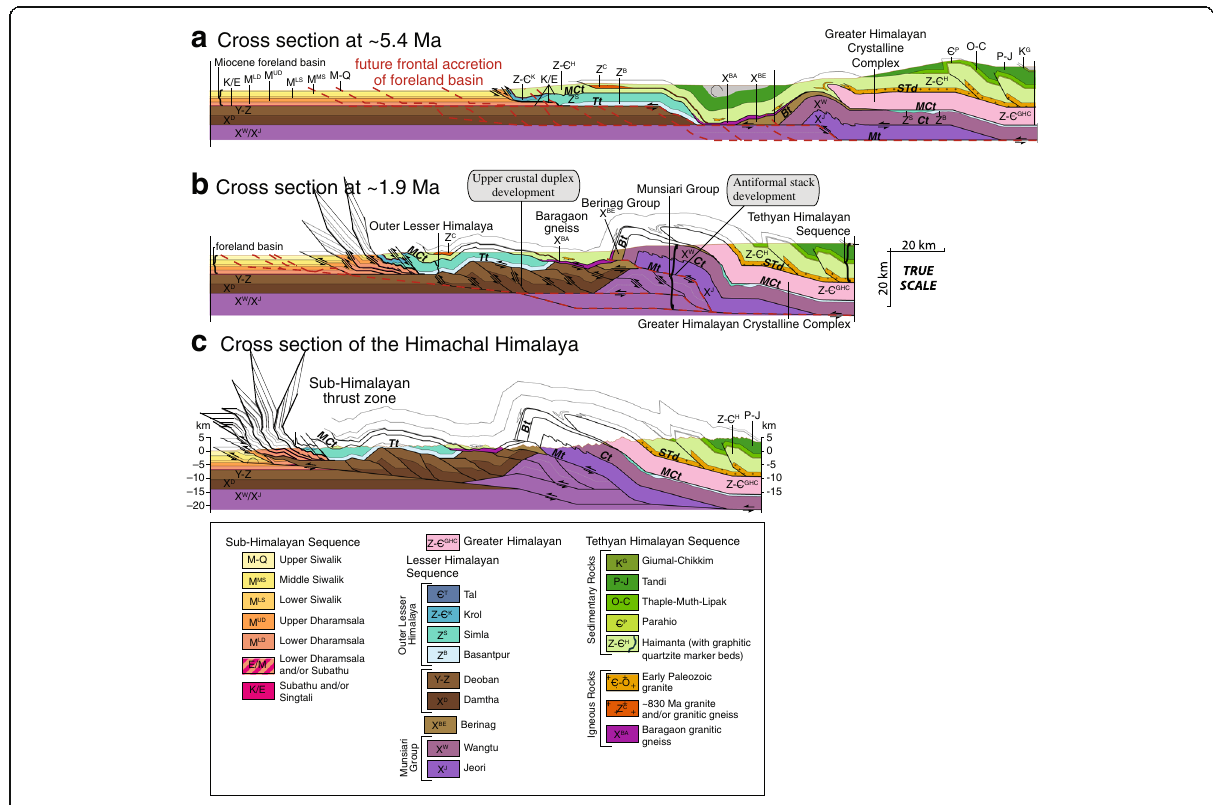
Fig. 11 Restorations of the Western Indian Himalaya by Webb (2013) at a ~5.4 Ma, b ~1.9 Ma and c the present day. Note that the crystalline Inner Lesser Himalaya and the Greater Himalaya are only predicted to breach the surface in this region after 5.4